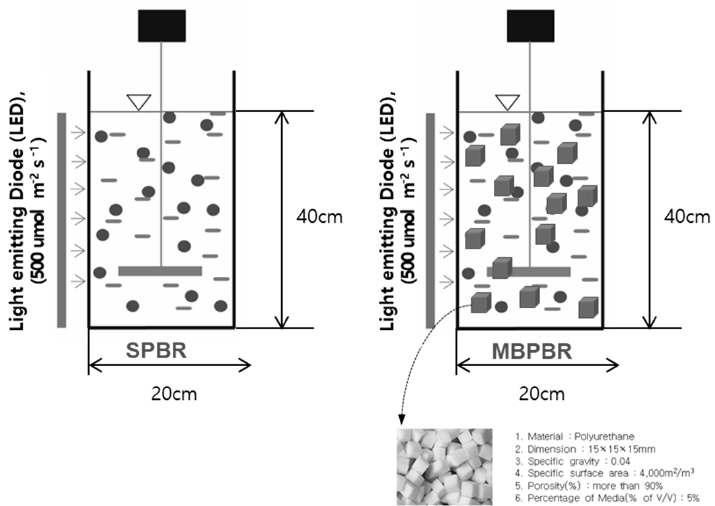
Figure 2. Schematic diagrams of the photobioreactor with moving media (MBPBR) and photobiore- actor without moving media (SPBR) used in this